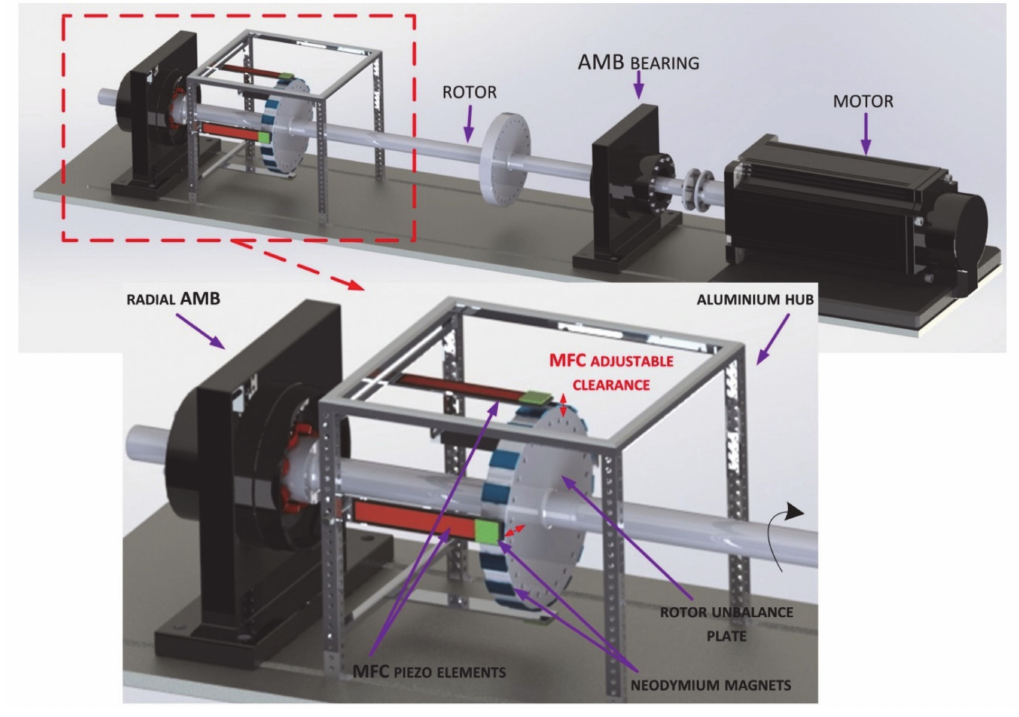
Figure 9. Test rig 3D model. Table 1. Fiber optic sensor